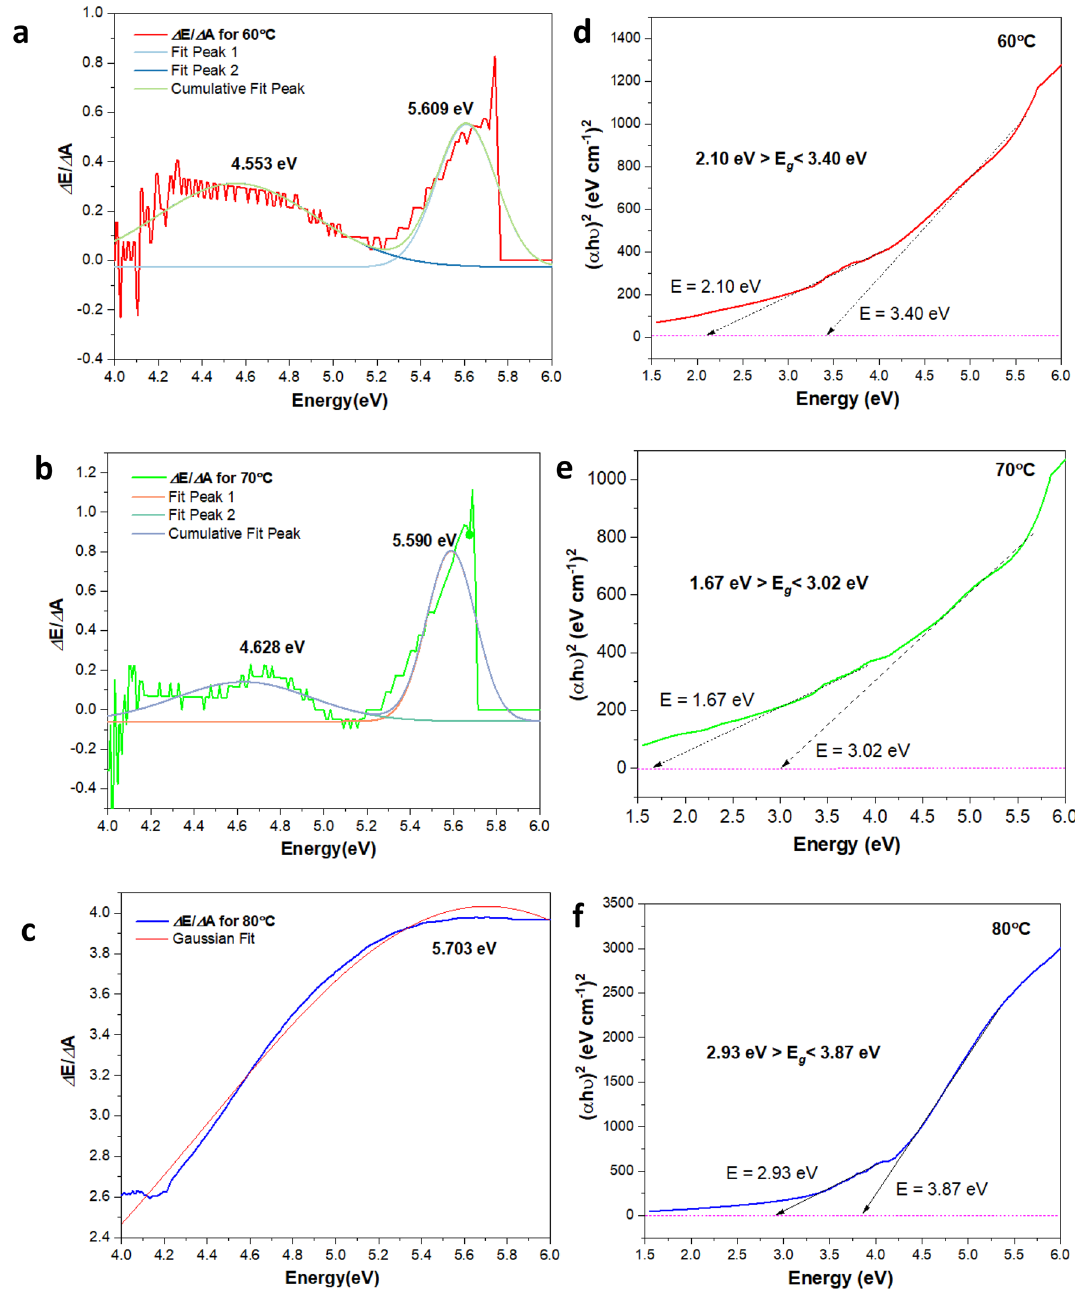
E (cid:31) A (left) and Tauc 2 vs energy (eV)